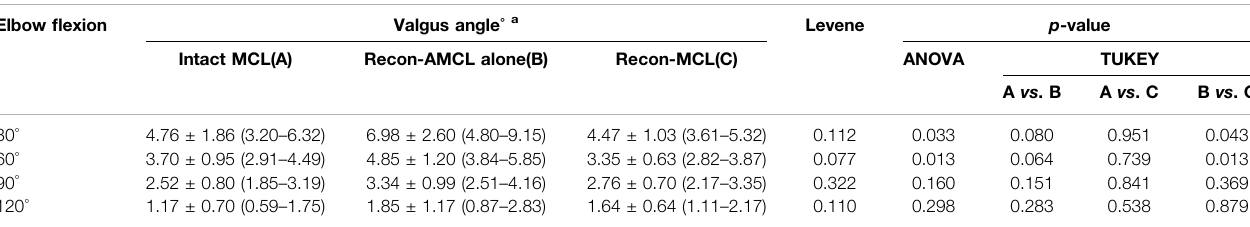
TABLE 2 | Valgus angle and statistical difference.